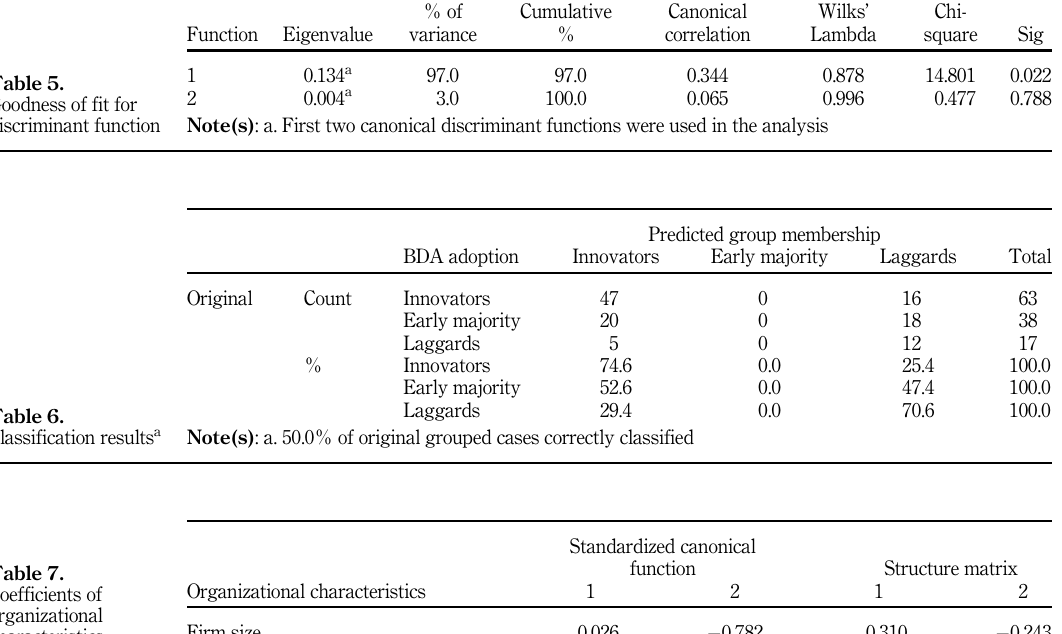
Table 7. Coefficients of organizational characteristics determining BDA adoption rate